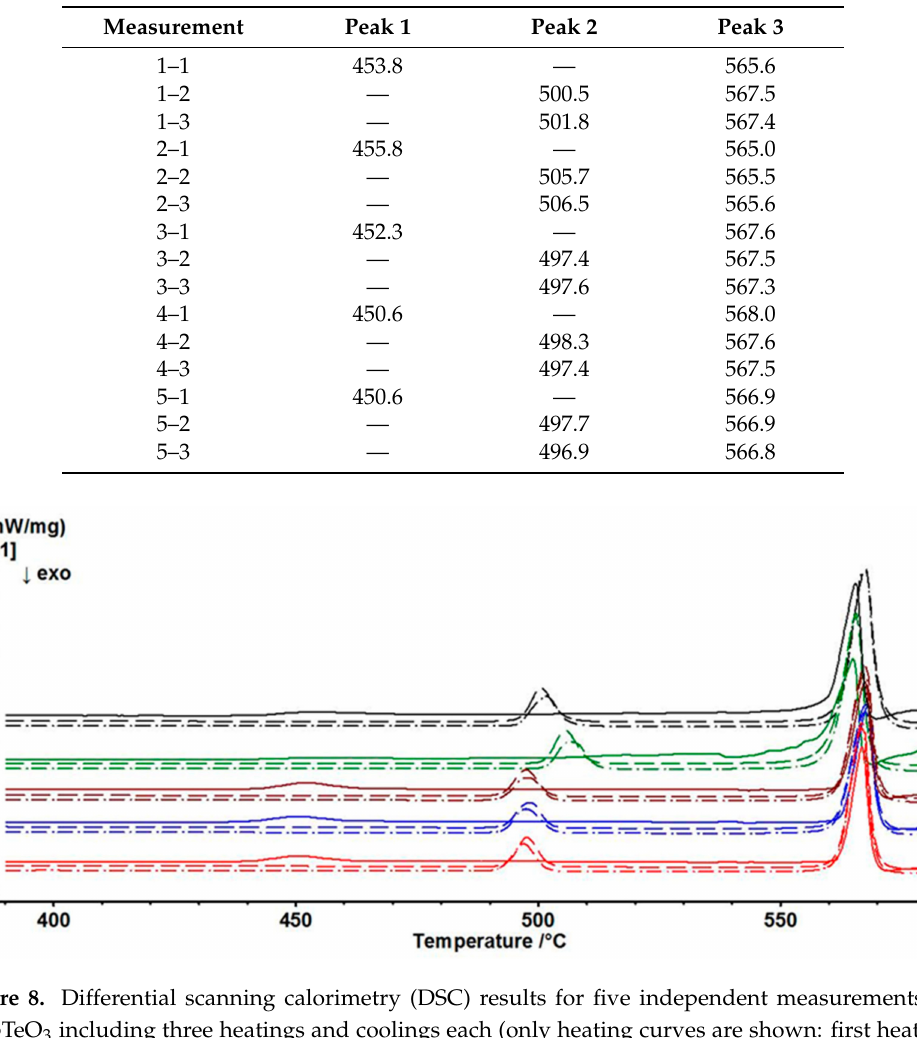
Table 3. Peak maxima ( ◦ C) of the endothermal effects during heating of γ -PbTeO 3 .